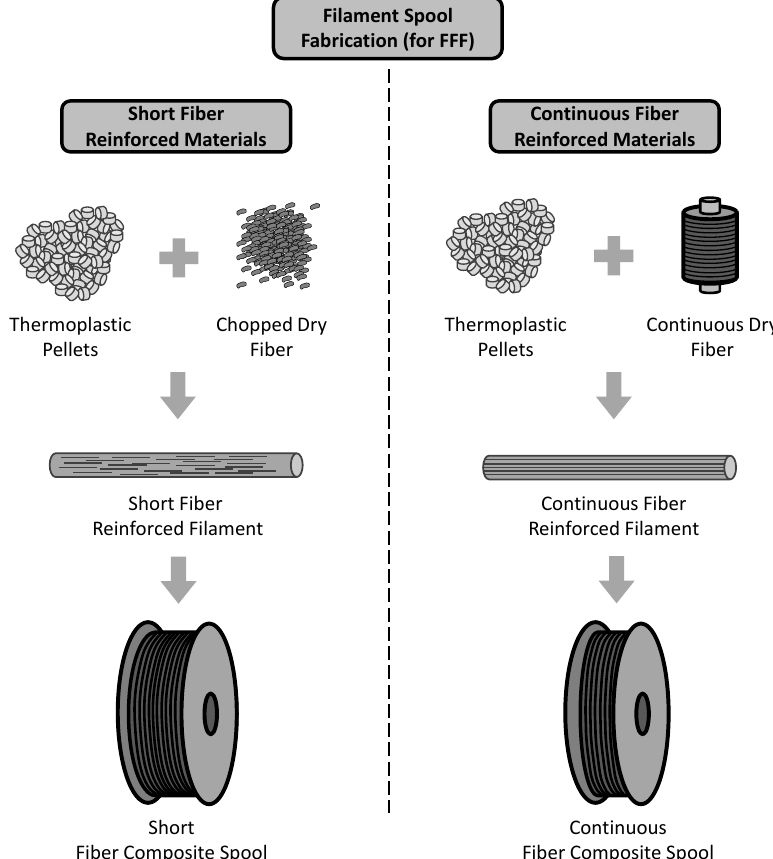
Figure 1. Schematic view of differences on the fabrication of short fiber reinforced 3D-printing filaments compared to continuous fiber reinforced 3D-printing